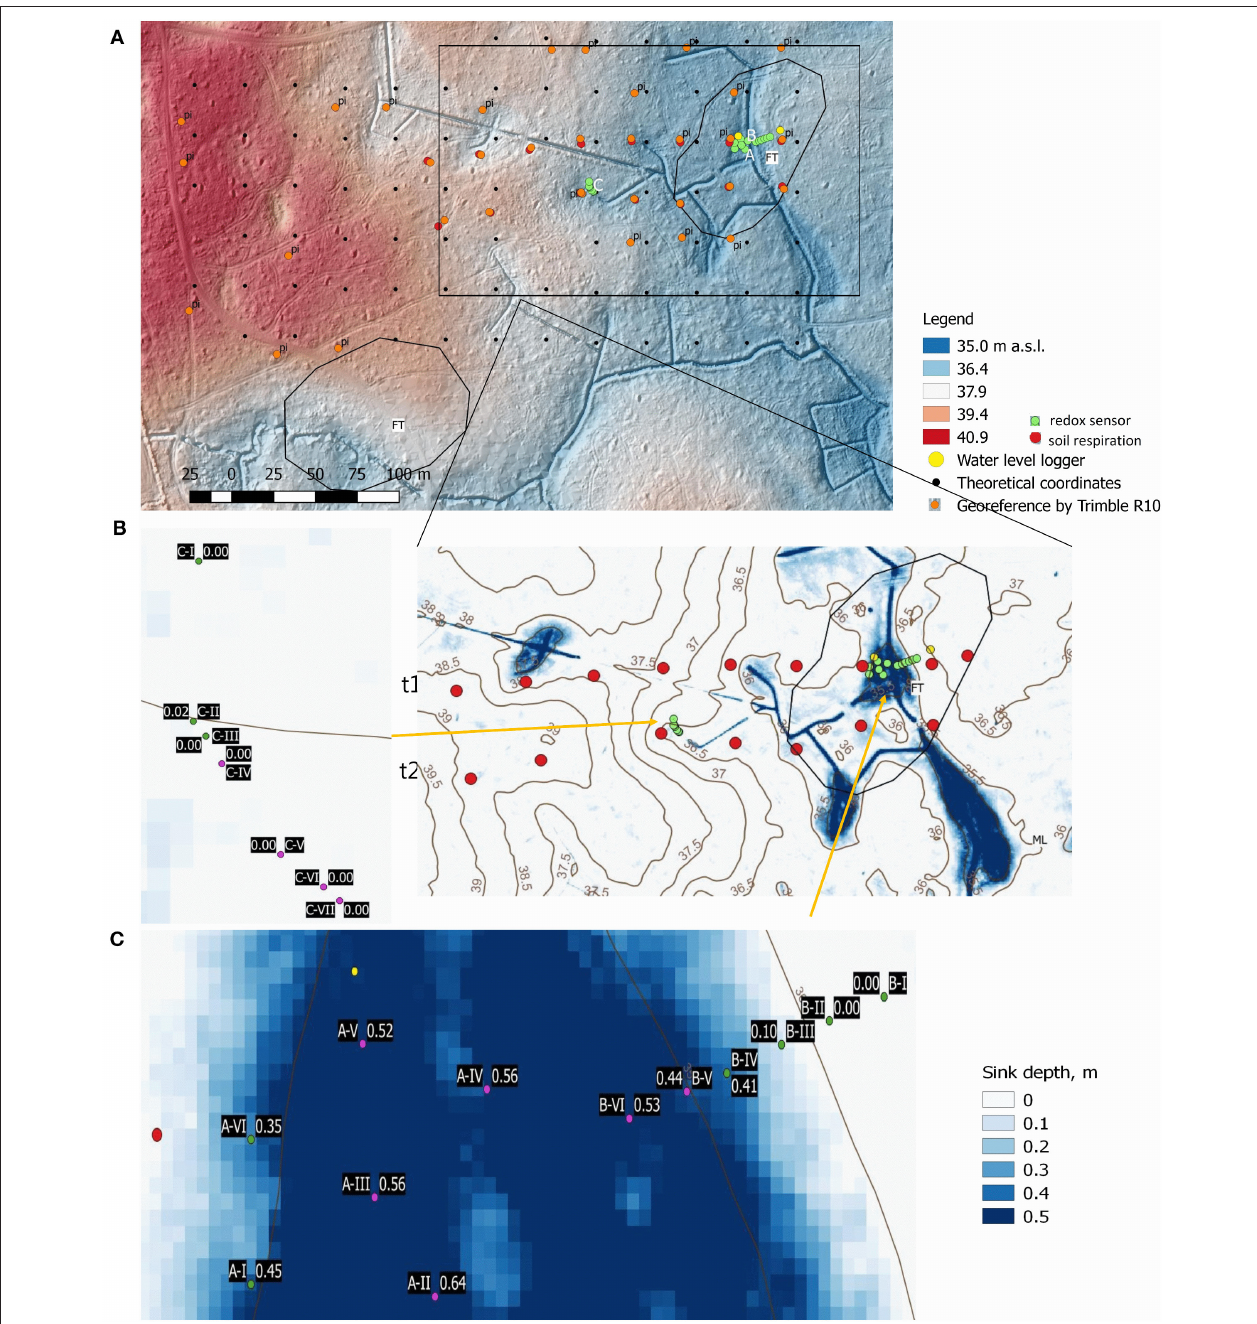
FIGURE 1 | (A–C) (green dots) – redox measurement points. Location of water level loggers: yellow dots. SOC sampling grid (theoretical coordinates): black. Same grid positioned by Trimble R10 ( p oles i dentified are labeled with “pi” label): orange dots. Soil respiration points: red dots. (A,B) Redox measurement points: green dots. The background is the DEM 0.4m. Black line polygons – FT – peat signature from legacy map. Lower maps: Measurement of redox potential (Eh) in groups of three Pt sensors (dots with labels: group ID and depth of TD, cm. Cyan color: anaerobic sequences observed during growing season). Soil respiration and litterfall measured at red points in east-west lines marked t1 and t2. Background – Bluespot map with elevation contour lines (brown, m.a.s.l.).